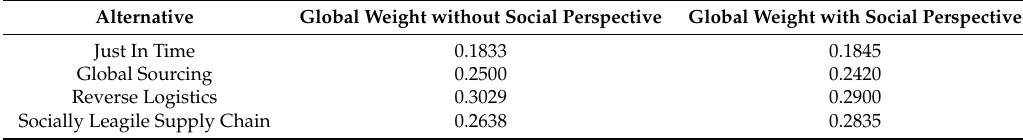
Table 8. Comparing Global weights of alternatives without and without Social